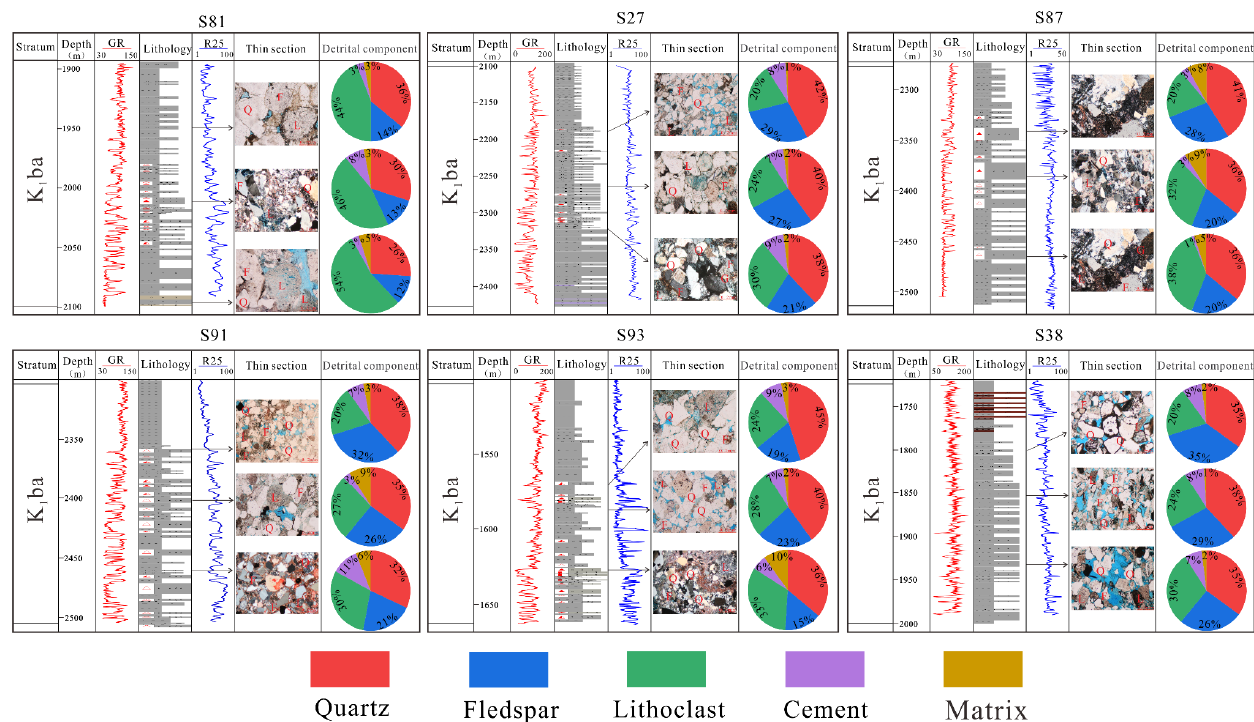
Figure 5. Characteristics of debrital components in A’ershan Formation in Saidong sub-sag, Saihantala sag. Abbreviations: Q: Quartz; F: Feldspar; L: Lithoclast; G: Granite. Energies 2022 , 15 , x FOR PEER REVIEW